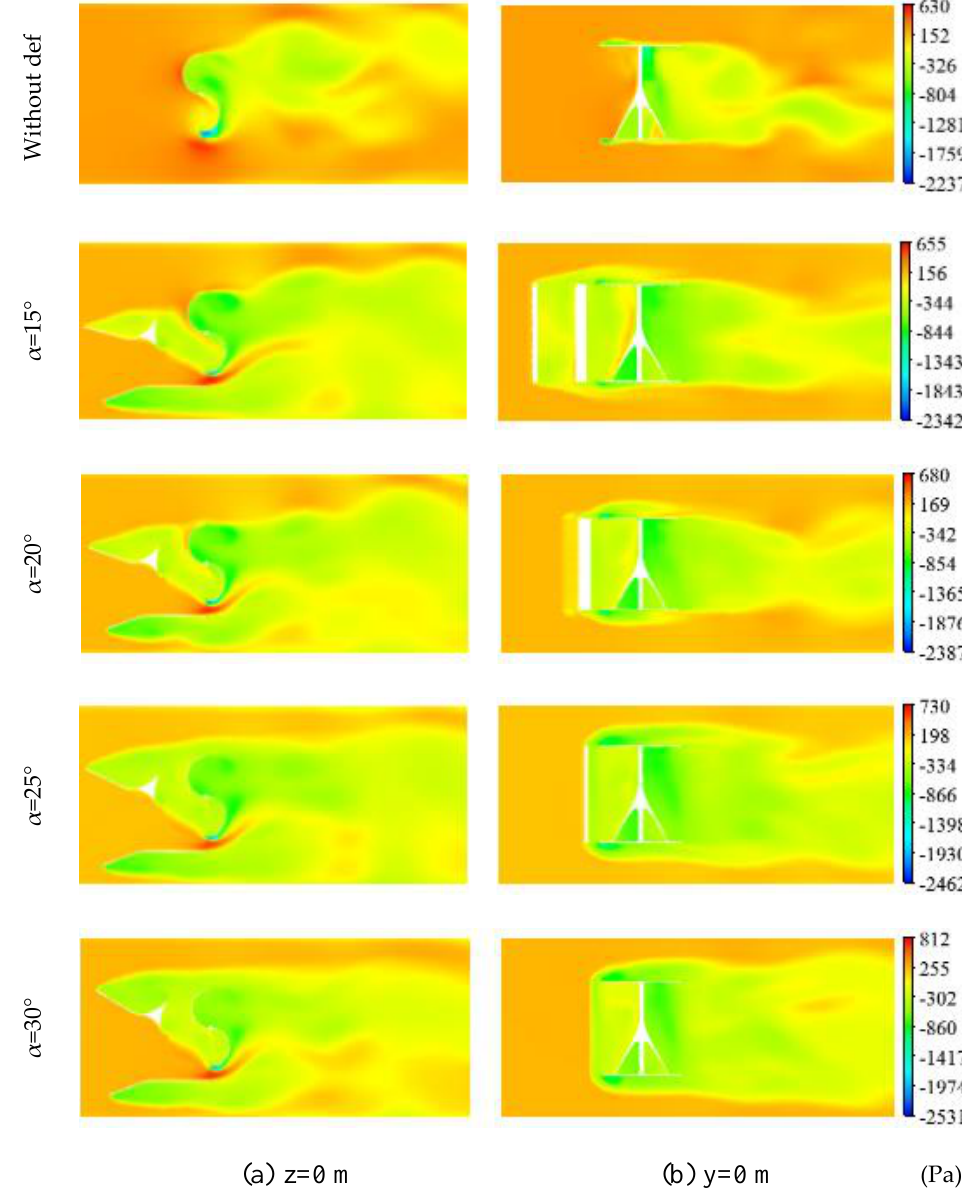
Figure13. Total pressure distribution for different deflection angles. 447 Figure 13. Total pressure distribution for different deflection